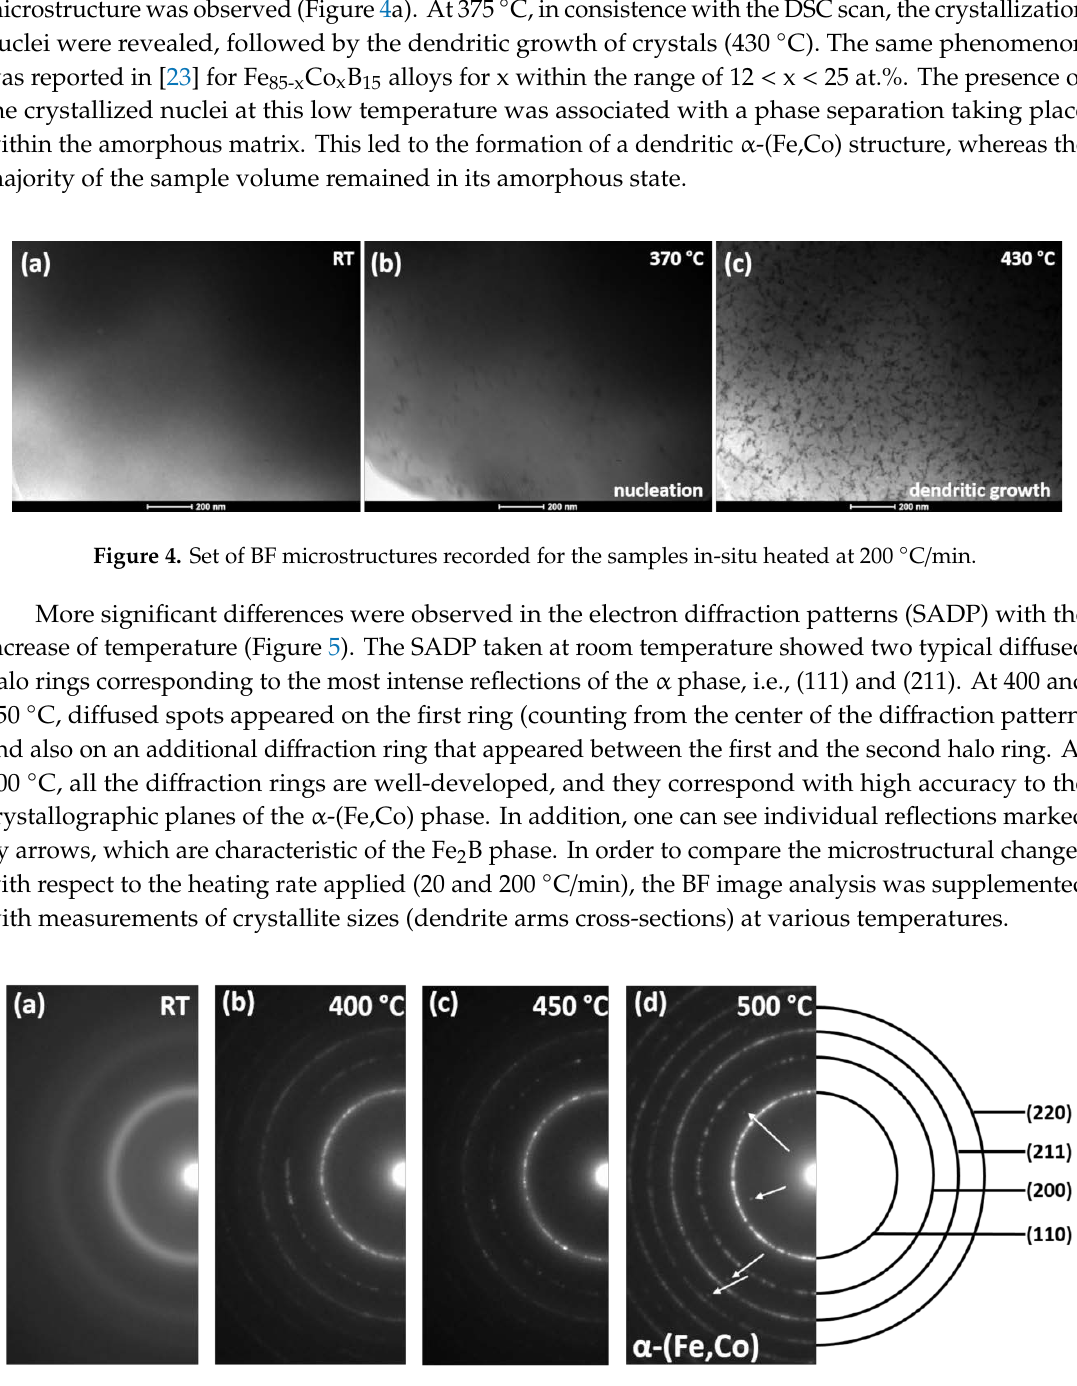
Figure 5. Electron diffractions patterns obtained at different temperatures for samples heated in situ with a heating rate of 200 °C/min.